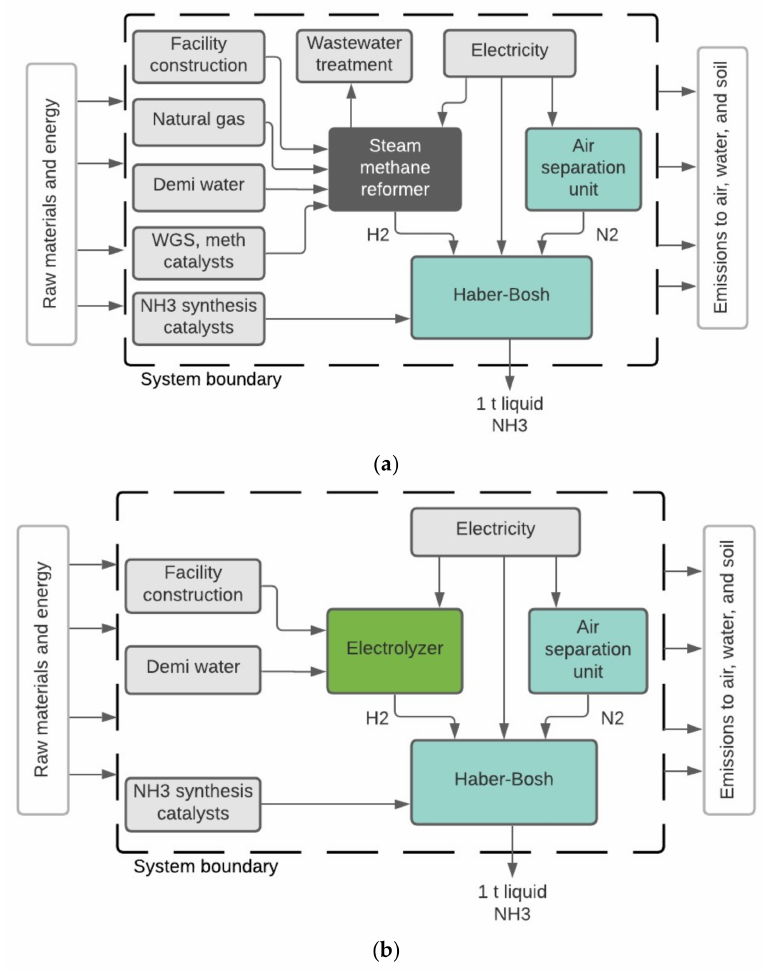
Figure 1. System boundaries of the ammonia production system: ( a ) based on natural gas via steam methane reforming to obtain hydrogen; ( b ) based on water via electrolysis to obtain hydrogen.